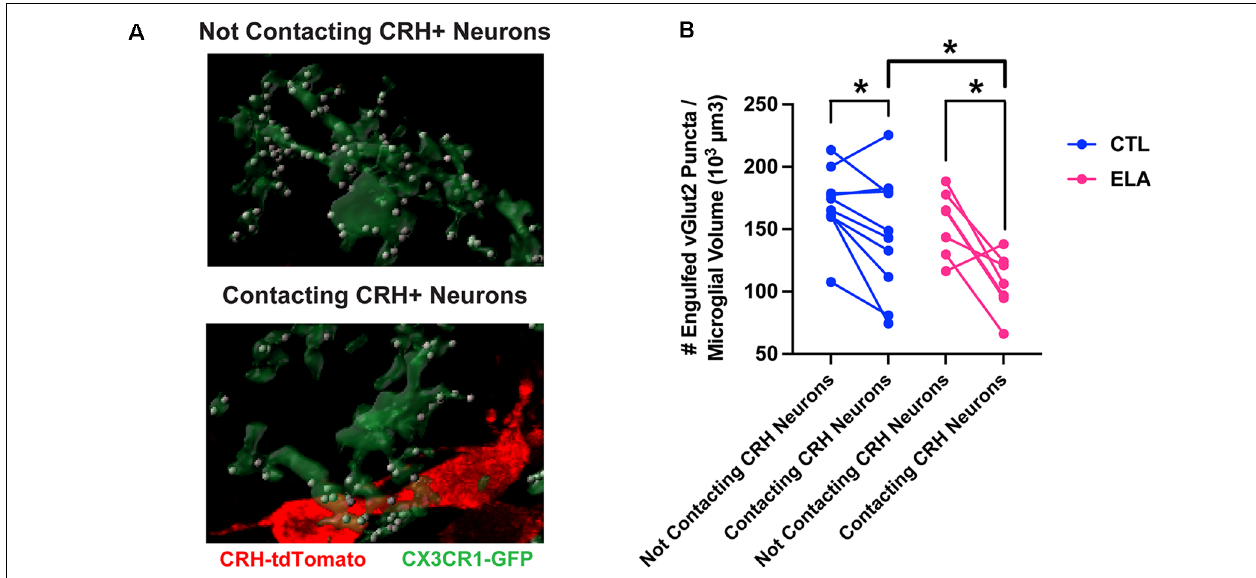
FIGURE 1 | Microglial subpopulations in the paraventricular nucleus of the hypothalamus (PVN) differ in their synaptic pruning levels based on CRH+ neuron contact. (A) Representative confocal images of 3D-reconstructed microglia (CX3CR1-GFP+; green) and their engulfed vGlut2+ synaptic puncta (white) in the subpopulations that contact CRH+ neurons (tdTomato+; red; bottom) and those that do not (top) in the PVN of a postnatal day (P) 8 male ELA mouse. (B) Only microglia in the PVN that are directly abutting CRH+ neurons are inhibited by ELA and prune fewer synapses compared to controls (unpaired t -test with Welch’s correction; CTL vs. ELA: contacting CRH+ neurons, t 13.9 = 2.22, p = 0.04). Furthermore, microglia contacting CRH+ neurons engulf fewer vGlut2+ synaptic puncta compared to microglia not contacting CRH+ neurons in both CTL and ELA mice at P8 (paired t -tests; CTL: contacting vs. not, t 9 = 2.46, p = 0.04; ELA: contacting vs. not, t 6 = 3.54, p = 0.01). Data are mean ± SEM. * p < 0.05. Adapted from Bolton et al.